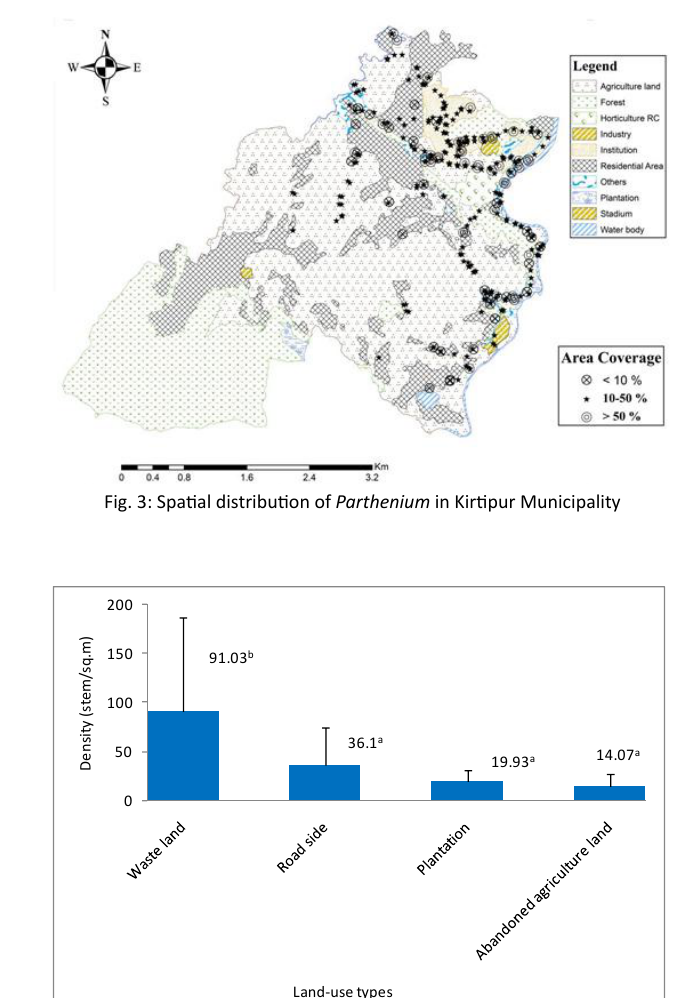
Fig. 4: Density of Parthenium in different land ‐ use types. The mean values were compared by ANOVA (F 3, 116 =13.95; P<0.001) followed by Duncan homogeneity test. The values with same alphabet in superscript are not significantly different at P=0.05